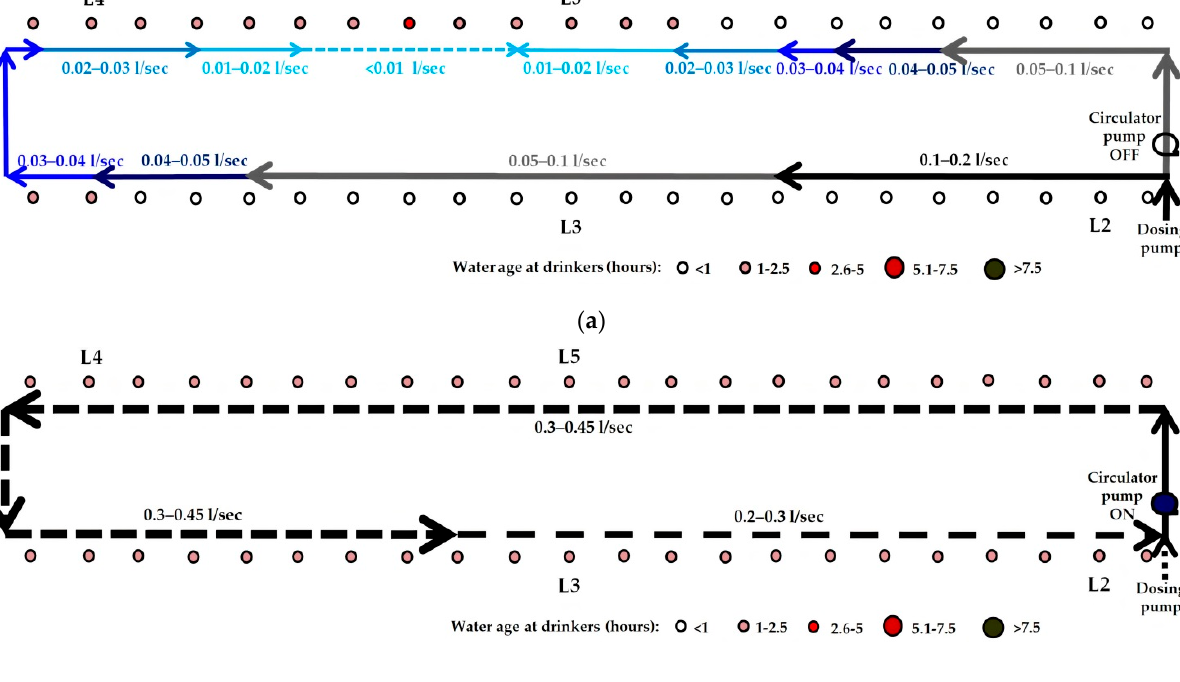
Figure 10. Network maps generated in EPANET, representing the WDSs in Building B at 12:00 noon (day 2) during: ( a ) Study 2a; and ( b ) Study 2b. Coloured arrows indicate the direction of water flow in each pipe section. Water flow rate (L/sec) along each pipe section is indicated by the size of the arrow and thickness of the line. The age of the water (in hours) at each drinker is indicated by the size and colour of the circle.